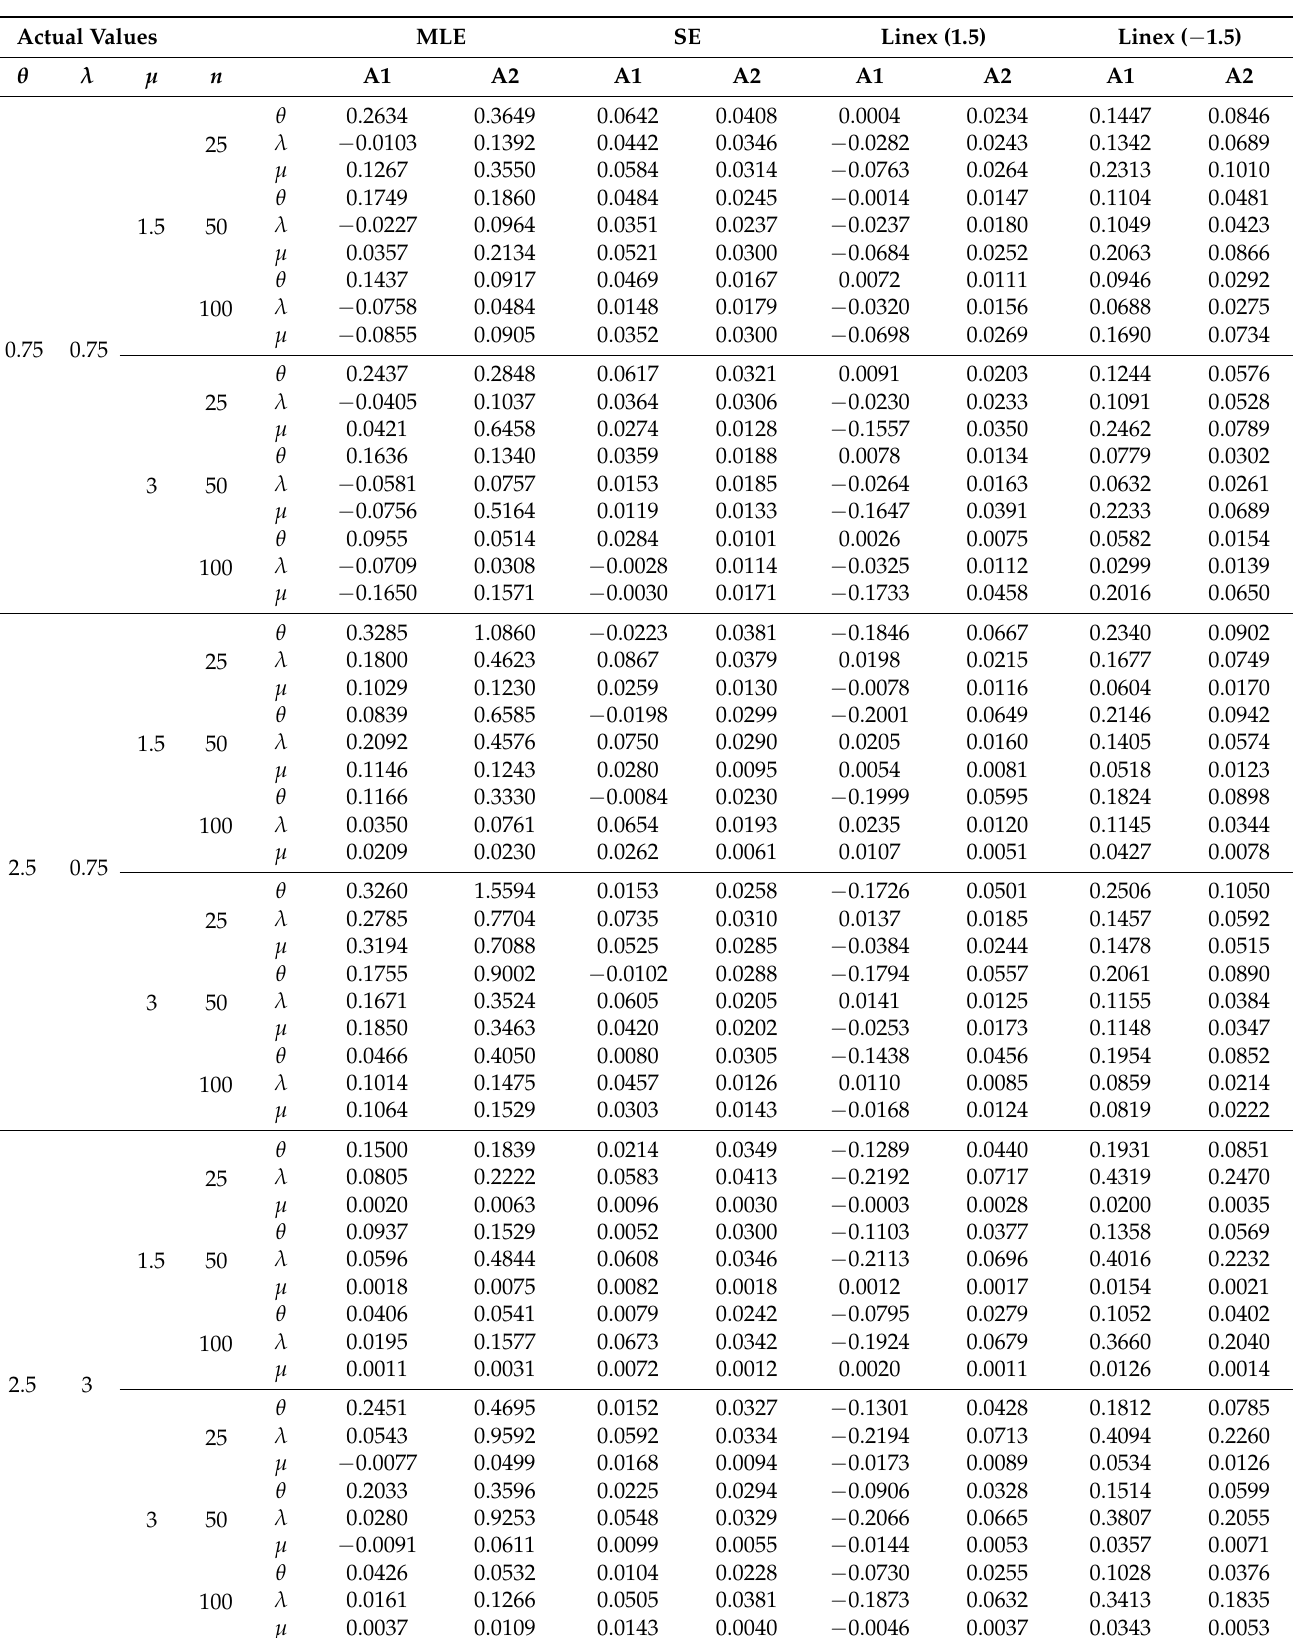
Table 1. MLE and Bayesian estimate for TCPWE model at complete